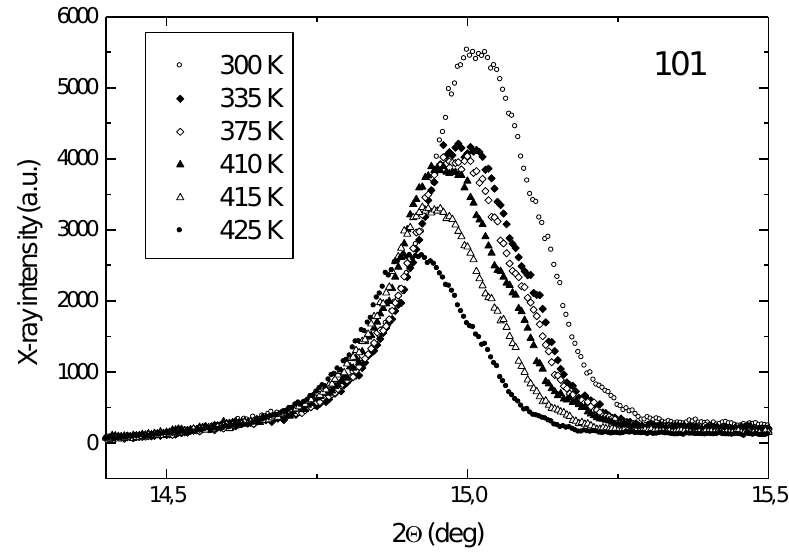
Figure 6. {101} XRD peak collected at increasing temperatures.